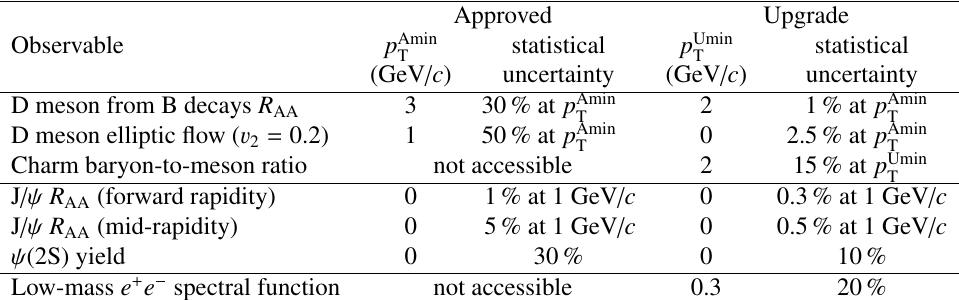
Table 1. Comparison of the physics performance for selected observables between the approved scenario (1 nb − 1 of delivered integrated luminosity, out of which 0.1 nb − 1 is used for minimum-bias data collection) and the proposed upgrade (10 nb − 1 of integrated luminosity). Given are minimum accessible p T and relative statistical uncertainty.